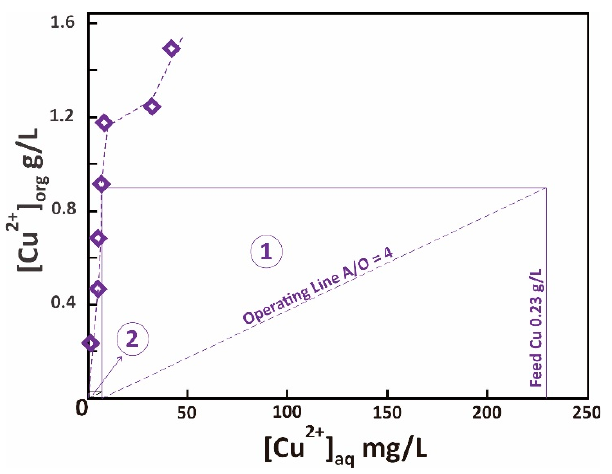
Figure 3. Extraction isotherm of Cu using LIX ® 84-I 10% v/v , pH 3, McCabe-Thiele plot is shown for A/O ratio 4.